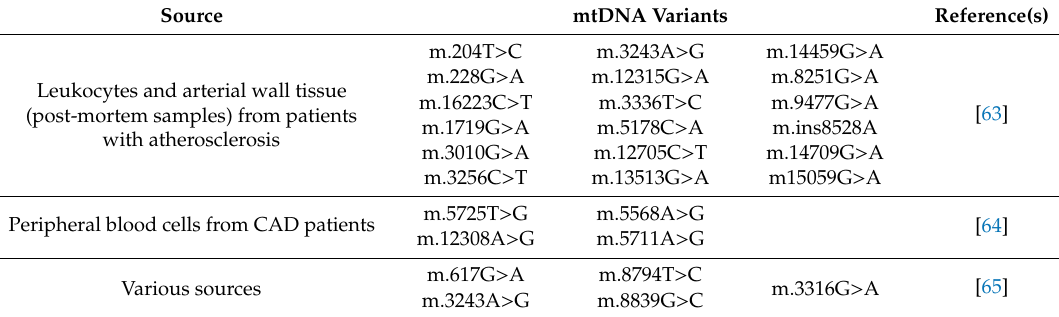
Table 1. mtDNA variants associated with